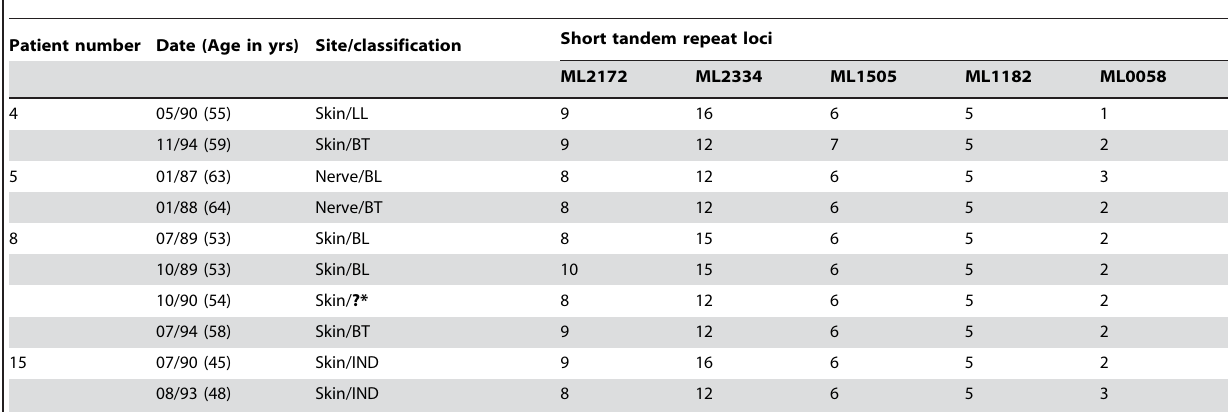
Table 5. Comparison of copy numbers of short tandem repeat loci from multiple biopsies taken from the same anatomical location at different times, from individual patients in